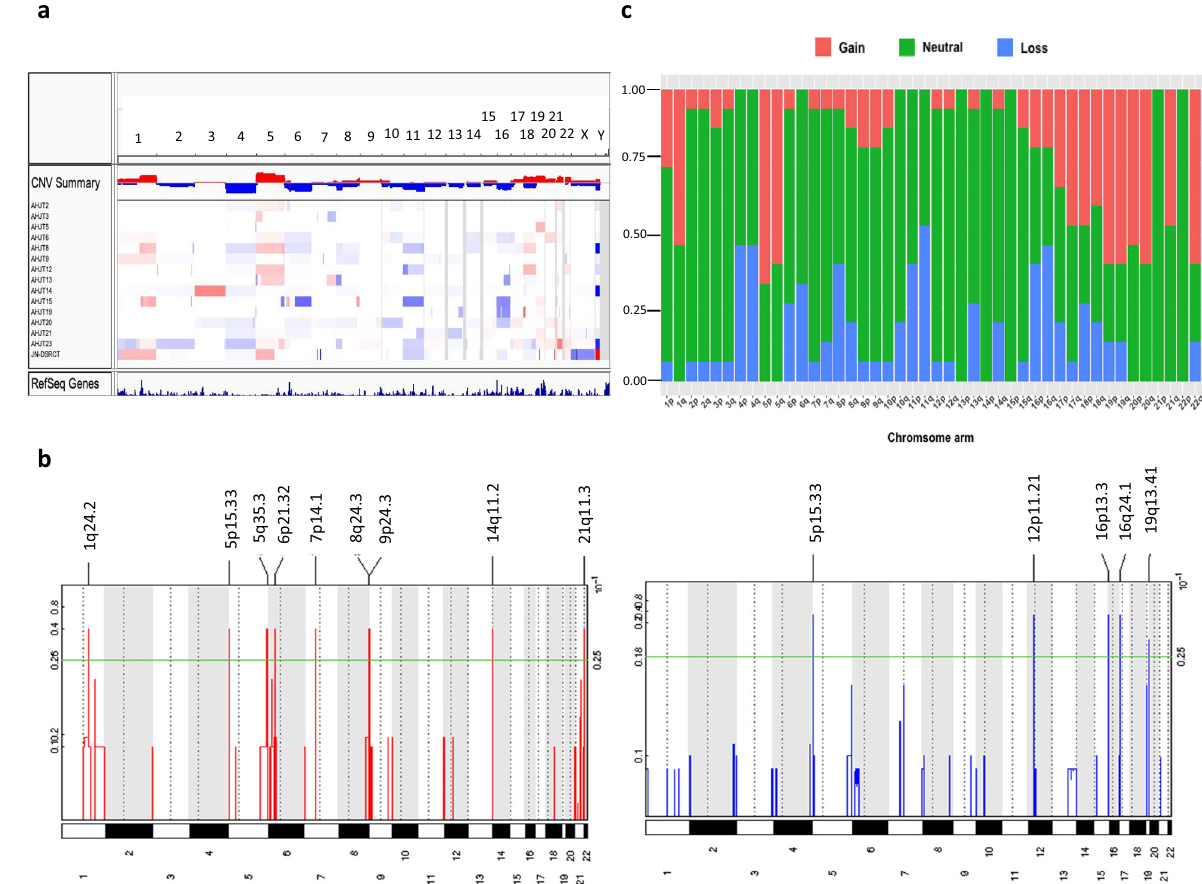
Fig. 2 Identi fi ed SCNAs in the DSRCT patients. a the SCNA pro fi les of all the 14 patients (copy number pro fi les of samples from the same patients were merged by aligning chromosome segments across samples of the same patient and then assigning the mean of copy number changes to the overlapping chromosomal segments and keeping the copy number changes of those sample-speci fi c segments). b Focal copy number alterations identi fi ed by GISTIC across the 14 patients. GISTIC q -values ( y -axis) for copy ampli fi cation (left, red) and deletion (right, blue) peaks were plotted across the chromosomes. The signi fi cance levels of focal events are shown as green lines. c Frequency of signi fi cant arm-level SCNAs identi fi ed by GISTIC. Arm-level SCNAs were considered signi fi cant with GISTIC q <